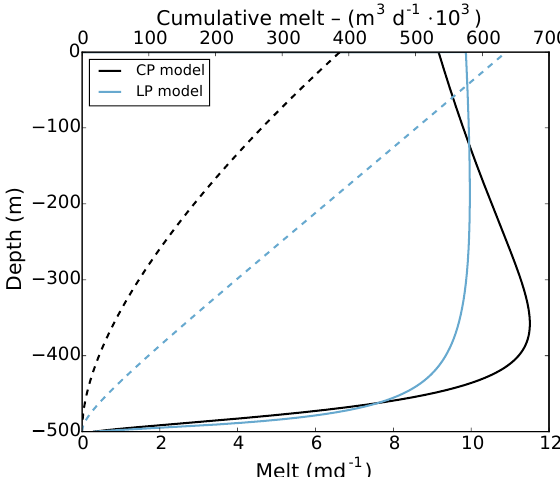
Figure 4. Melt rate profiles in a well-mixed fjord simulated by the CP model (black) and LP model (blue) for a width W = 150m and the total discharge of Q sg = 500m 3 s − 1 . In the case of the CP model the total discharge is delivered through one channel in the center of the glacier; in the case of LP model the discharge is Q sg = 3 . 6m 2 s − 1 . Both uniformly distributed with the rate q sg = W plumes start with a velocity of U 0 = 1ms − 1 . Solid lines show melt rate averaged across the plume in the case of CP model and across the full width W in the case of LP model. The dashed line shows the corresponding cumulative melt rate for the entire